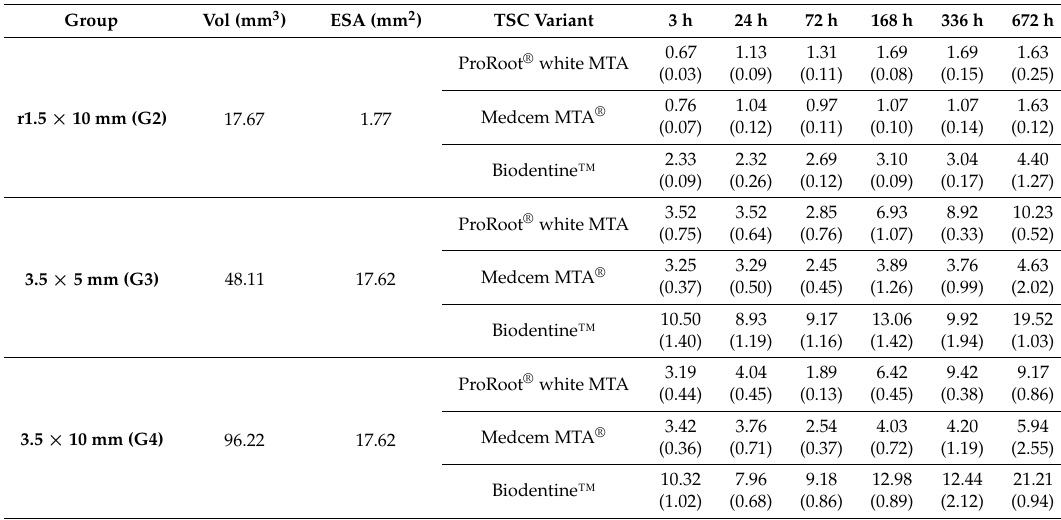
Table 3. ∆ pH as a function of sample dimensions (varying Vol and ESA) with corresponding standard deviation ( n = 6) between parentheses at different time intervals.